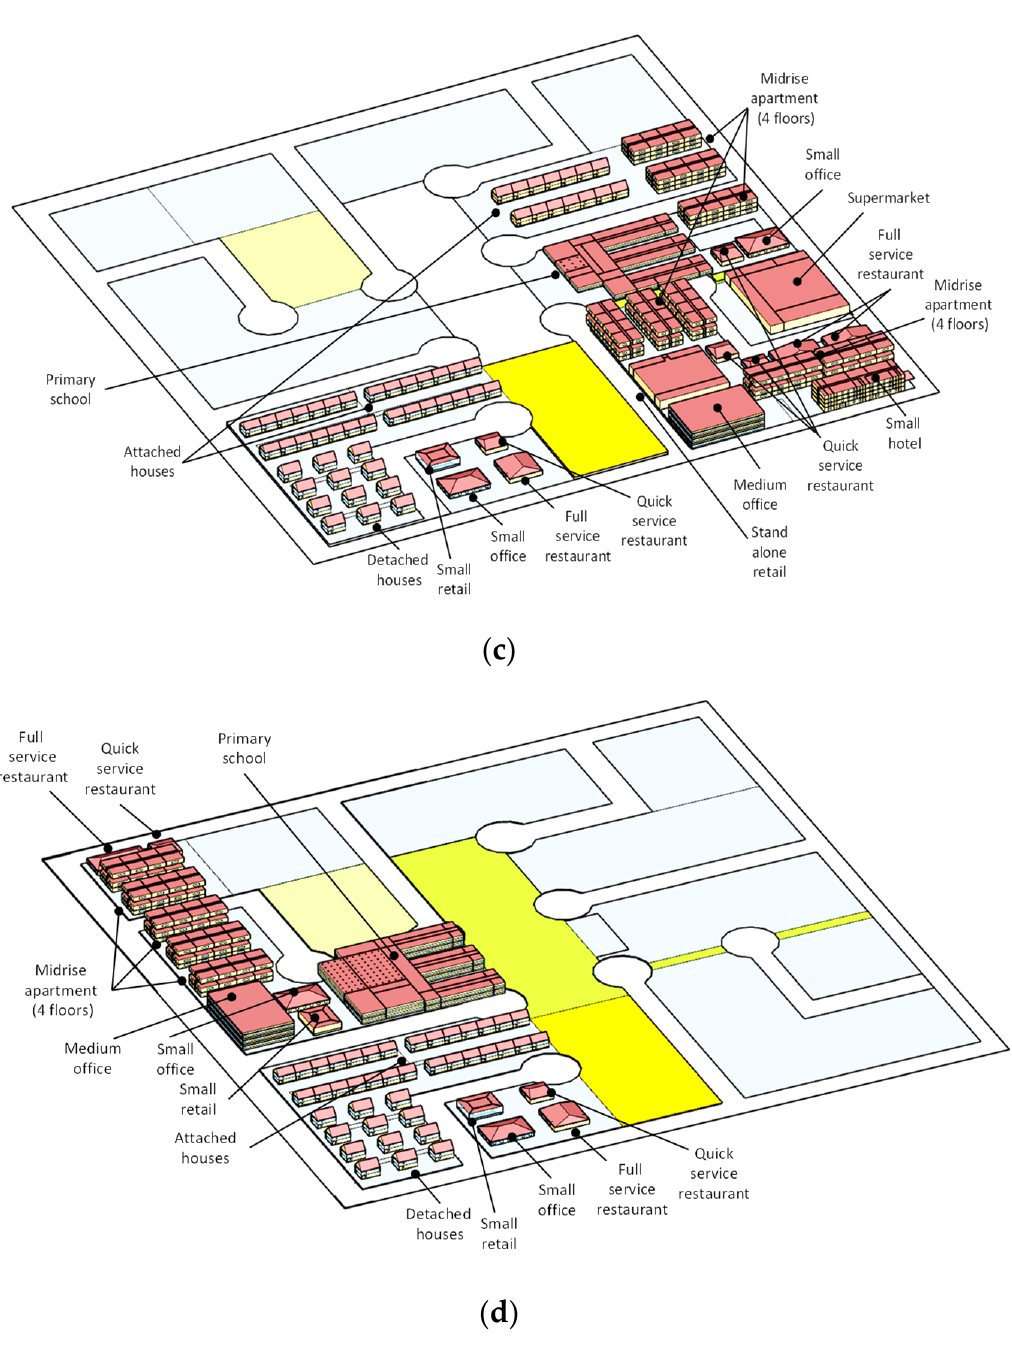
Figure 1. Three ‐ dimensional representation of various NU combinations ( a ) C 1 ; ( b ) C 2 , ( c ) C 3 ; ( d ) C 4.